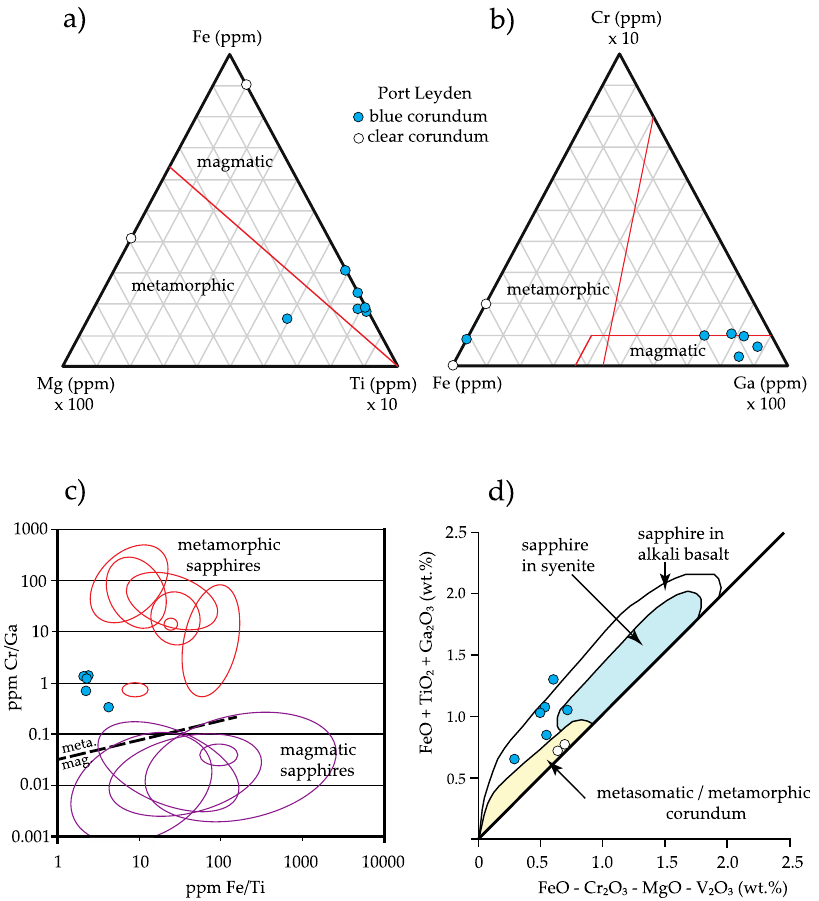
Figure 8. Trace element variation diagrams for sapphire origin along with data from the Port Leyden microsapphires. ( a ) Fe – Mg(×100) – Ti(×10) ternary plot adapted from [41], ( b ) Cr(×10) – Fe – Ga(×100) ternary plot adapted from [42,46], ( c ) Cr/Ga versus Fe/Ti plot adapted from [42]. Red and violet ellipses from metamorphic and magmatic deposits, respectively, ( d ) sapphire-bearing portion of FeO + TiO 2 + Ga 2 O 3 versus FeO – Cr 2 O 3 – MgO – V 2 O 3 plot adapted from [2], Cr-rich ruby deposits not shown.